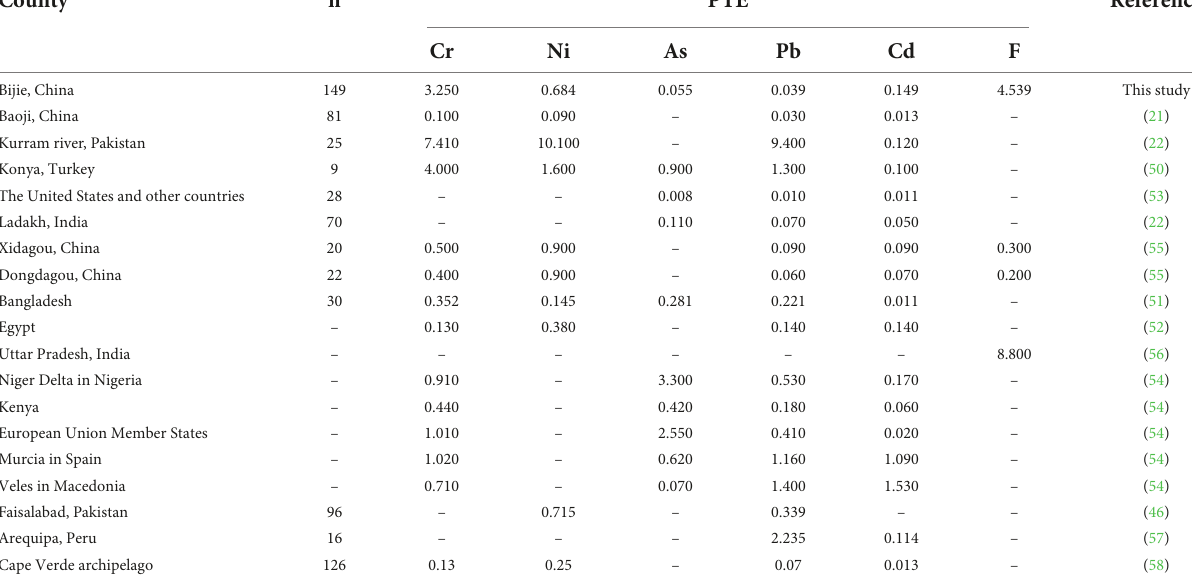
TABLE 4 Comparison of PTE concentrations in wheat grains from other studies (mg/kg). County n PTE